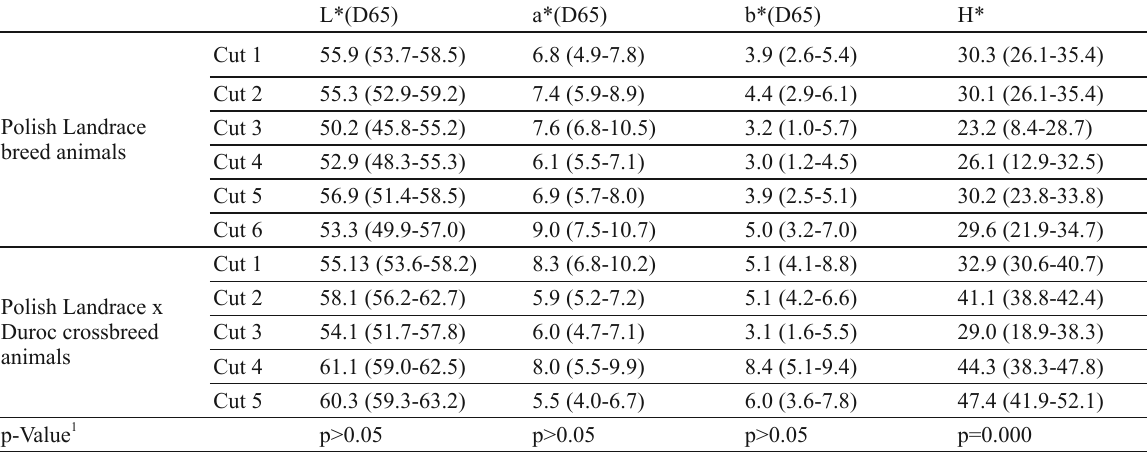
The median (min - max) values of meat color of Polish Landrace breed animals and Polish Landrace x Duroc crossbreed